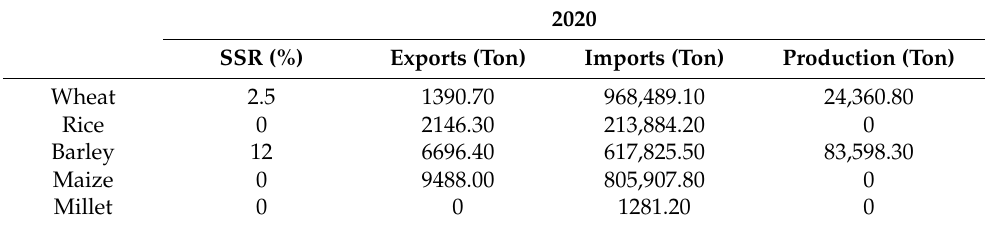
Table 4. Self-sufficiency ratio of cereal (2020)